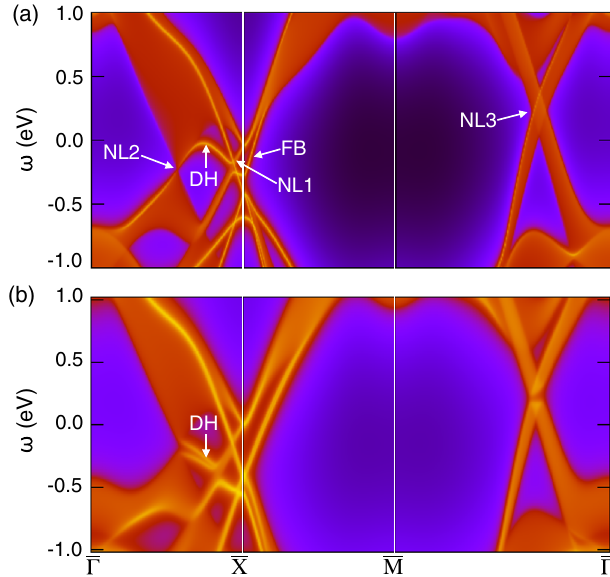
FIG. 4. Surface spectral function of ZrSiTe (001) along surface high-symmetry lines without SOC (a) and with SOC (b). NL1 and NL2 are the surface projections of the slightly gapped bulk nodal lines in the k z ¼ 0 and k z ¼ π planes. The DH emerges from the nodal line NL1 and merges into the bulk states derived ¯ ¯ from NL2. Along X- M, a FB surface state can be observed, while the projection of the bulk nodal line NL3 that connects NL1 with ¯ ¯ Γ NL2 can be observed along M-